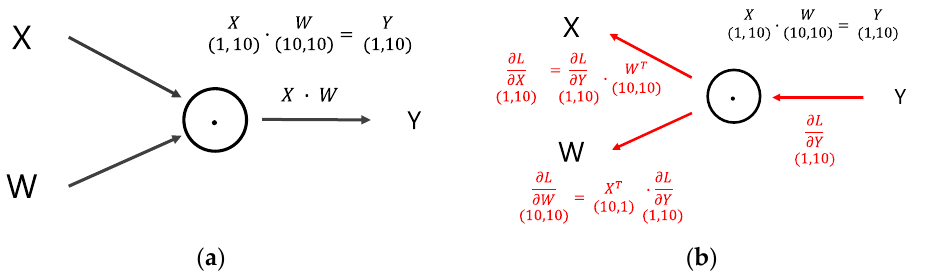
Figure 3. Operation of fully connected layer ( a ) in the inference process and ( b ) in the training process.